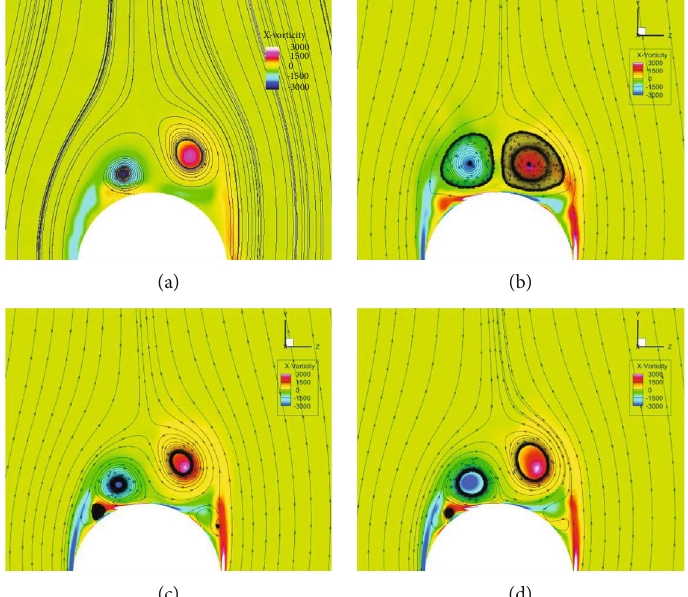
Figure 10: X -vorticity contour comparison at section 2: (a) PIV experiment, (b) result of Grid 1, (c) result of Grid 2, and (d) result of Grid